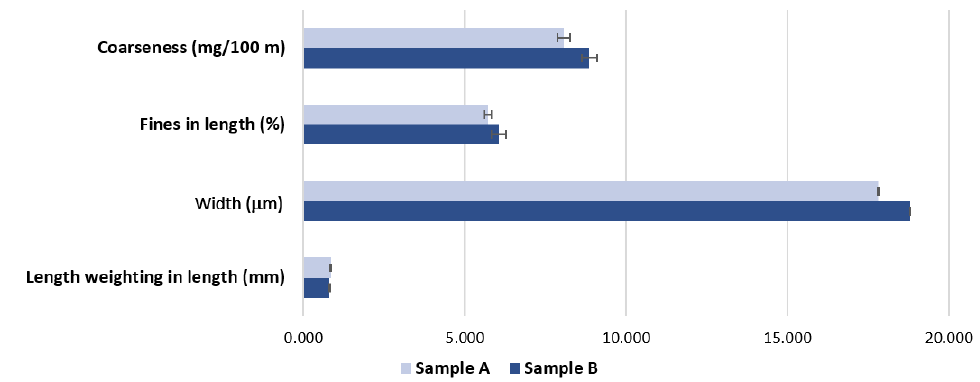
Figure 4. Morphological characterization of the two base tissue paper samples.